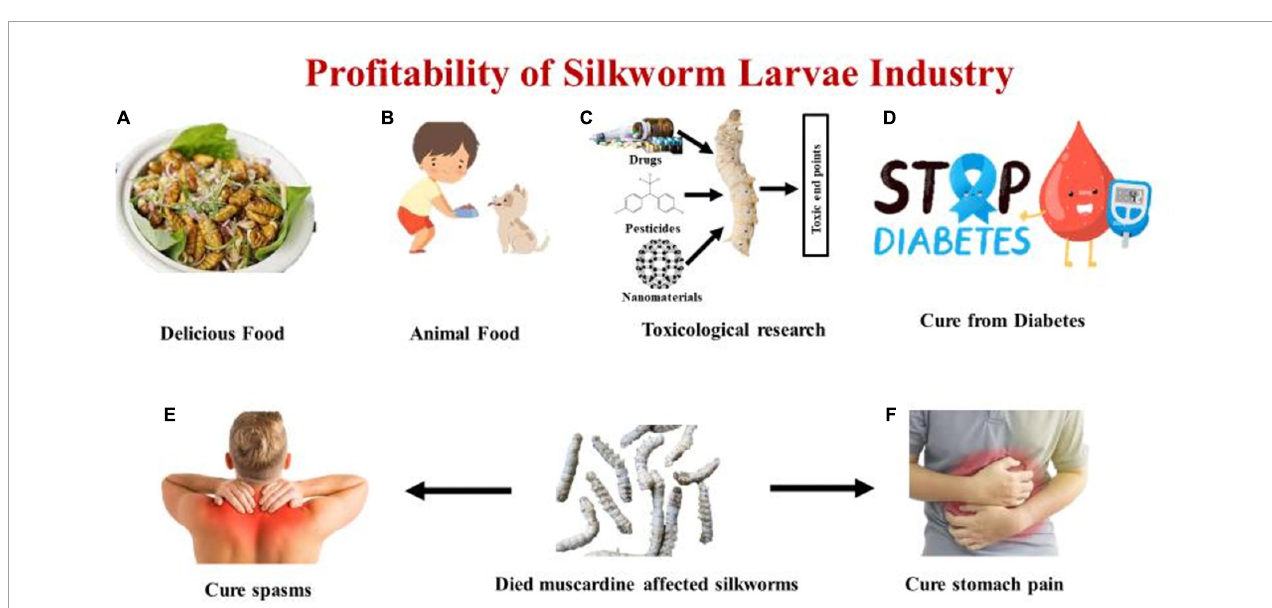
FIGURE2 Representing (A) Delicious food prepared from silkworm larvae. (B) Silkworm larvae used as animal food. (C) Silkworm larvae used as toxicological research studies for drugs, pesticides, nanomaterials. (D) Silkworm larvae used for curing blood sugar level (Diabetes). (E) Died fungus affected silkworm larvae curing body spasms. (F) Died fungus affected silkworm larvae curing stomach pain.